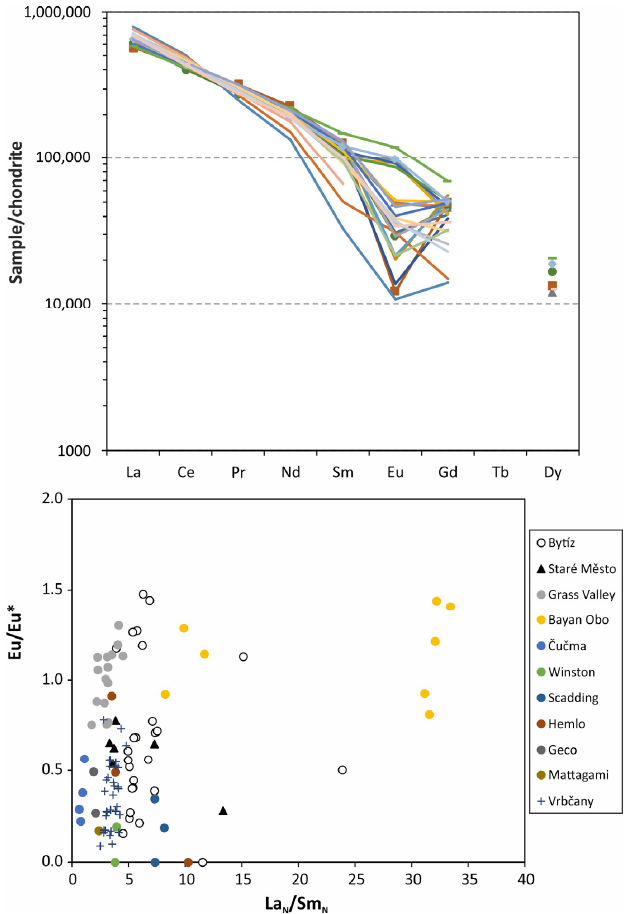
Figure 21. ( a ) Chondrite-normalized REE patterns of monazite. ( b ) The Eu/Eu* vs. La CN /Sm CN plot for monazite from Bytíz in comparison with other hydrothermal monazites. Comparative data are from Zhu and O ʼ Nions [78]; Schandl and Gorton [79]; Števko et al. [80]; Taylor [81]; Dolní č ek et al. [63] and Dolní č ek and Ulmanová [82].